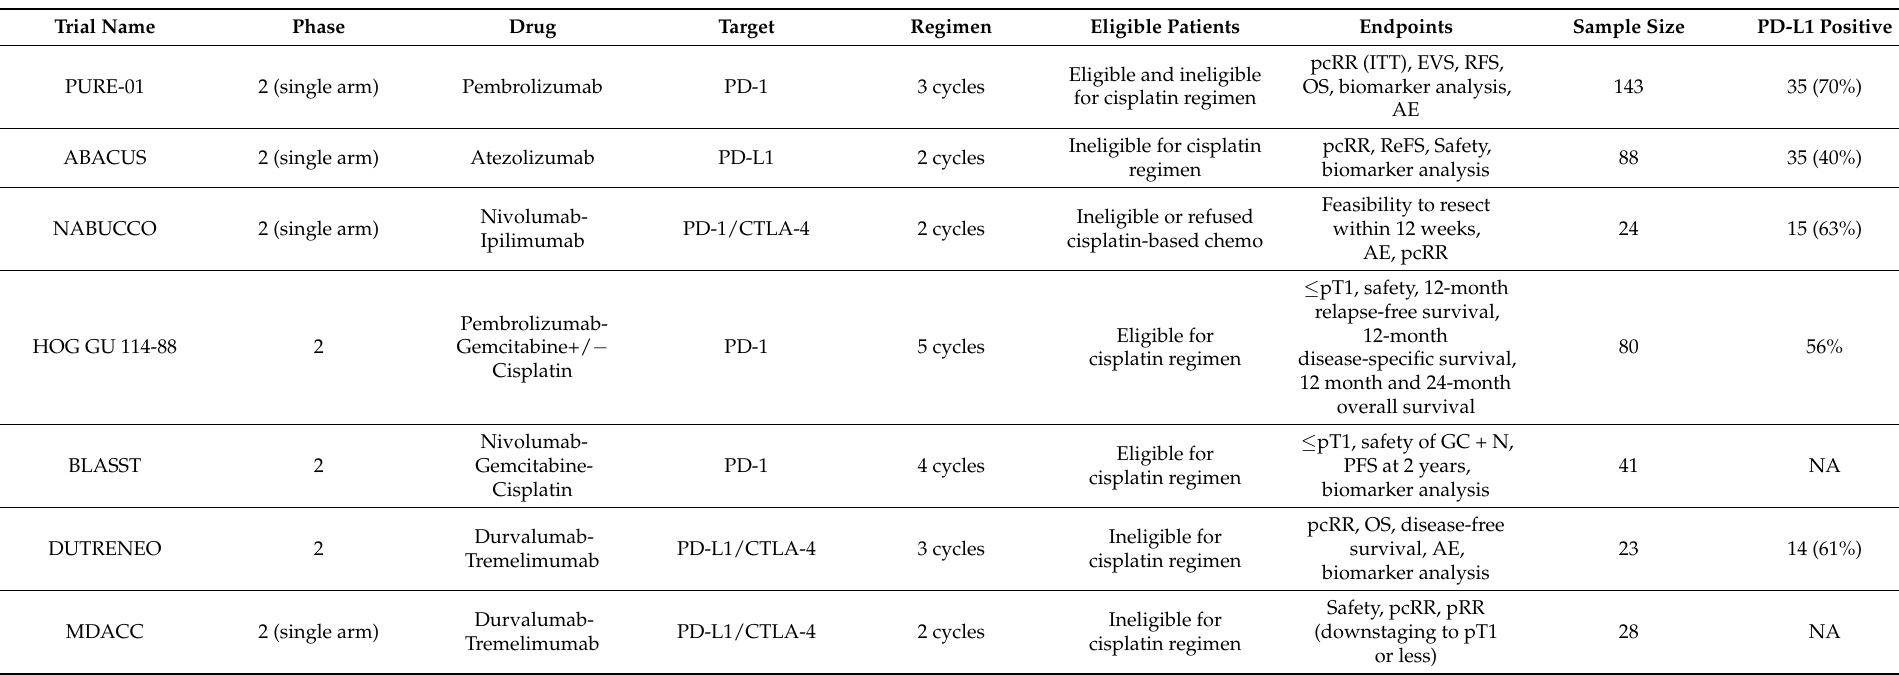
Table 1. Available published or communicated studies on neoadjuvant ICIs in muscle-invasive non-metastatic bladder